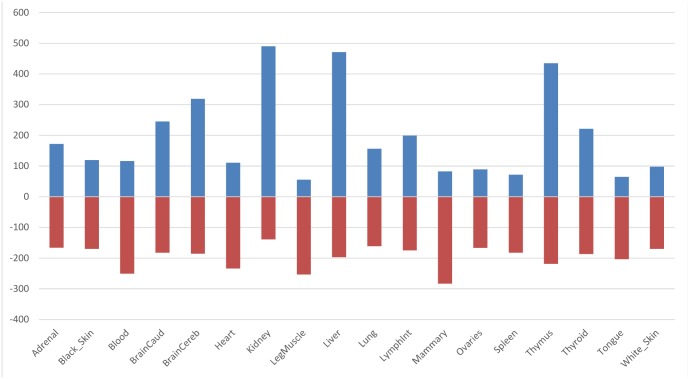
Average number of differential expressed class 3 transcripts that are either upregulated or downregulated.This graph shows us the average number of class 3 putative lncRNA transcripts that are either upregulated (blue bars) or downregulated (red bars). We see that in the tissues kidney, liver and thymus there are, on average, more upregulated transcripts, while in the tissues leg muscle, ovaries, spleen and tongue there is, on average, more downregulated transcripts.